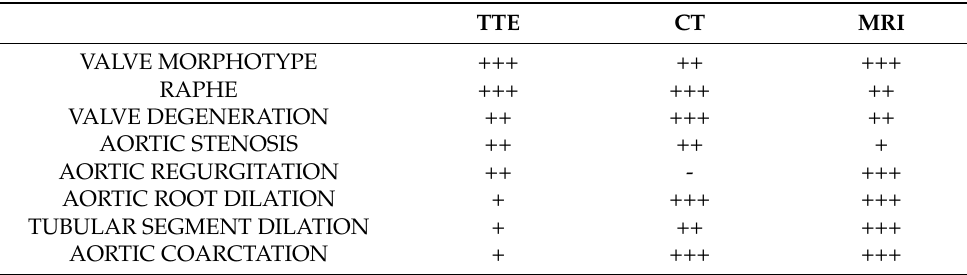
Table 1. Comparison of imaging modalities for diagnostic features of bicuspid aortic valve. TTE— transthoracic echocardiography; CT—computed tomography.